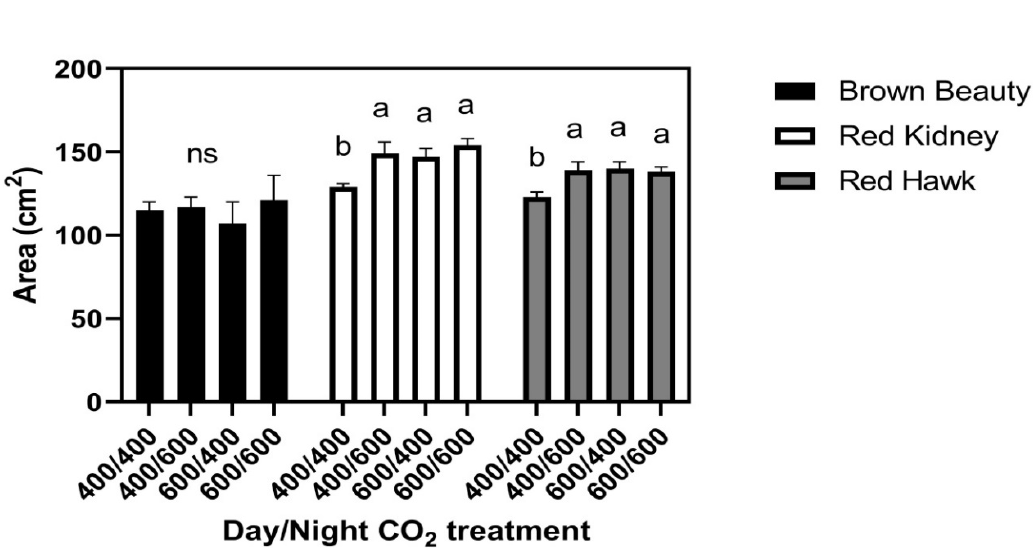
Figure 3. Area of terminal leaflets of third mainstem trifoliolate leaves of six cultivars of common bean grown with four day/night CO 2 concentrations ( µ mol mol − 1 ), with day/night temperatures of 26/20 ◦ C. Bars indicate standard deviations, and different letters within cultivars indicate differences among CO 2 treatments, using ANOVA at p = 0.05, and ns indicates no significant differences among CO 2 treatments.